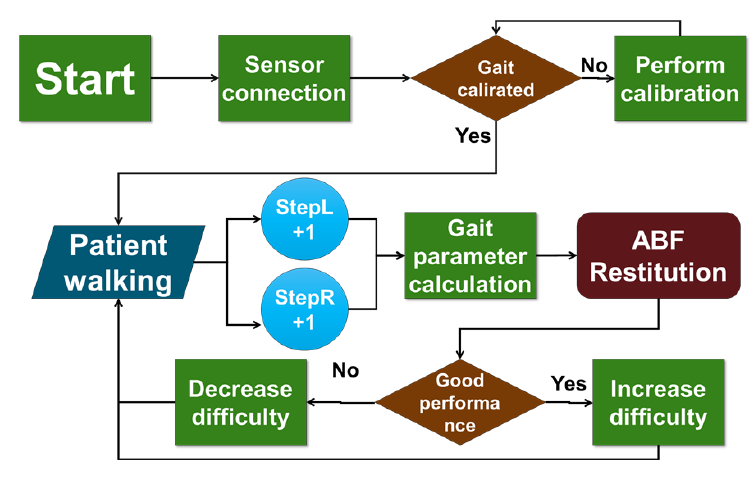
Figure 7. Block diagram of the audio feedback